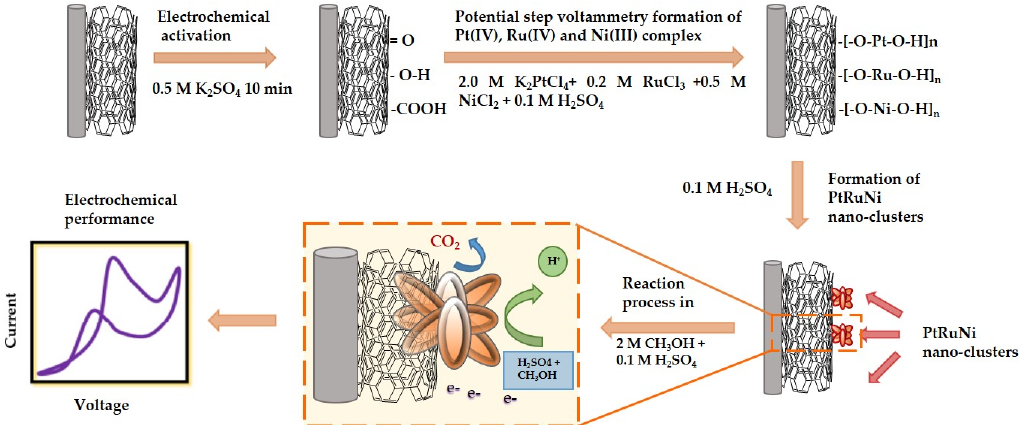
Figure 3. Schematic illustration of electrodeposition of PtRuNi on electrochemically activated MWCNTs and its enhanced catalytic performance towards methanol oxidation reaction [52].